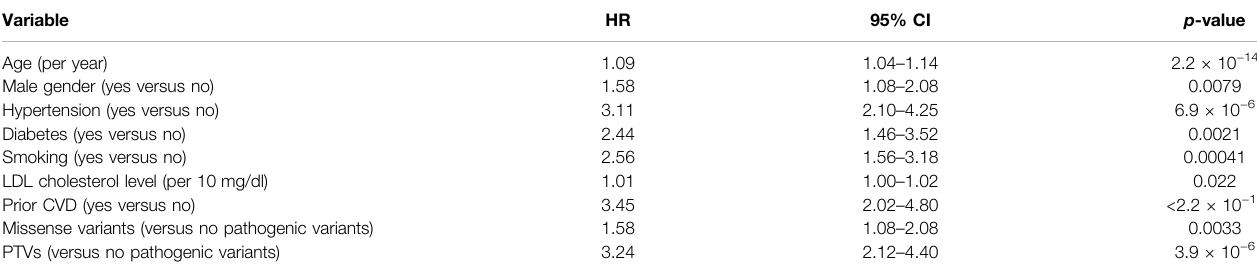
TABLE 4 | Factors associated with MACEs.